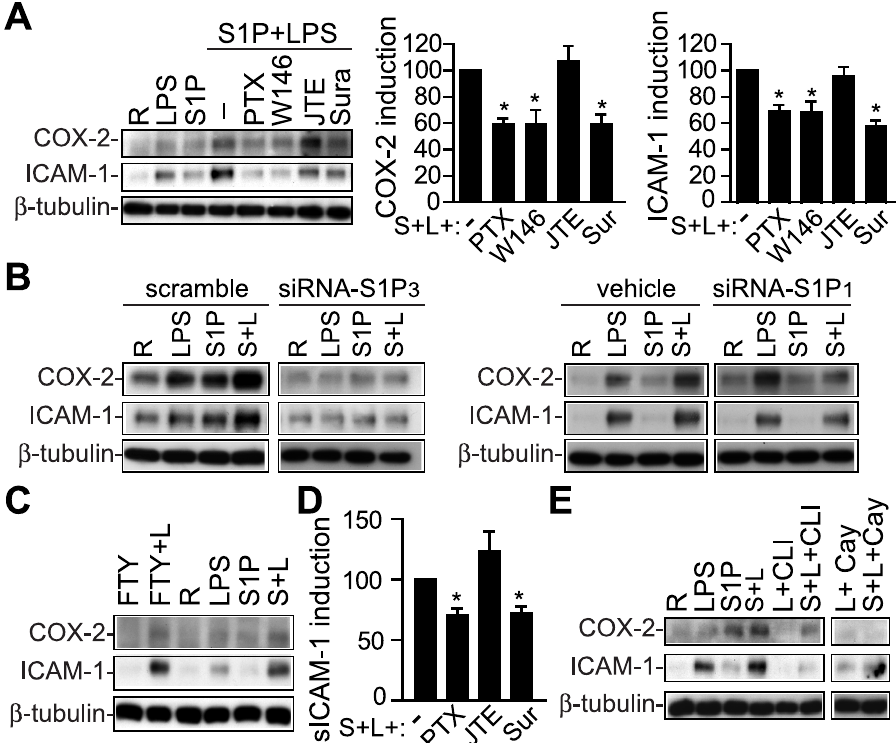
Figure 4. Receptors involved in the cooperative effect. AVICs were pre-treated with the indicated drugs, activated for 12 h, and cell lysates and supernatants were analyzed by Western blot and ELISA, respectively. A) Representative immunoblots with densitometry data demonstrate inhibition of the cooperative effect on COX-2 and ICAM-1 expression (100% value) using S1P 1/3 antagonists (n=6–12). B) Silencing S1P 1/3 attenuated the cooperative effect (n=3 control AVIC). Scramble, siRNA control; vehicle, 0.1% DEPC. C) Immunoblots showed cooperation between FTY720 and LPS (n=3). D) ELISA quantification of sICAM-1 levels show inhibition by S1P 1/3 antagonists (n=6–10). E) Immunoblots demonstrate inhibition of the cooperative effect by TLR4 antagonists (n=3). Cay indicates 5 m M CAY10614; CLI, 3 m M CLI-095; FTY, 1 m M FTY720; JTE, 10 m M JTE-013; S + L, S1P + LPS; PTX, 100 ng/ml pertussis toxin; R, resting; Sur, 10 m M suramin; W146, 10 m M W146. * p , 0.05 vs. S1P + LPS.